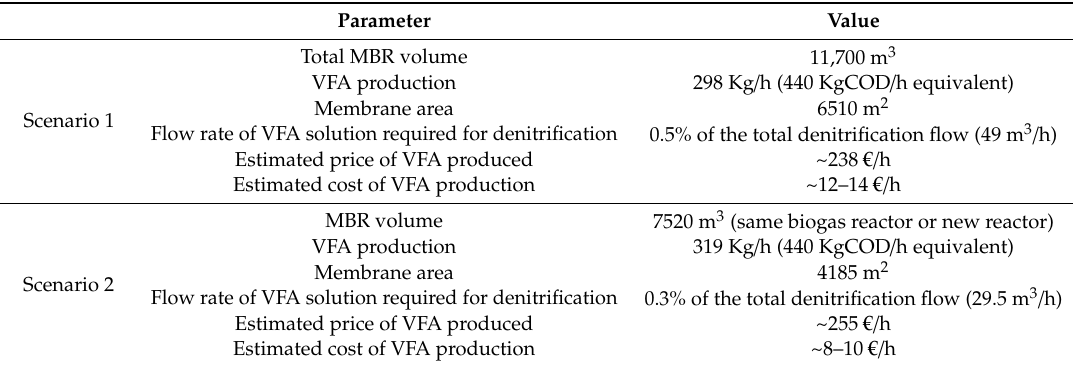
Table 4. Process conditions and the overall performance of scenario one and